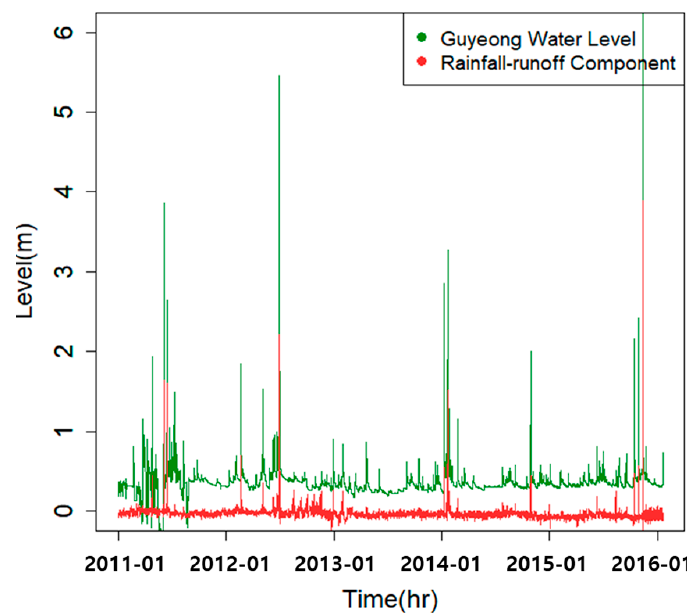
Figure 11. Comparison between Guyeong stream water level and rainfall-runoff component.